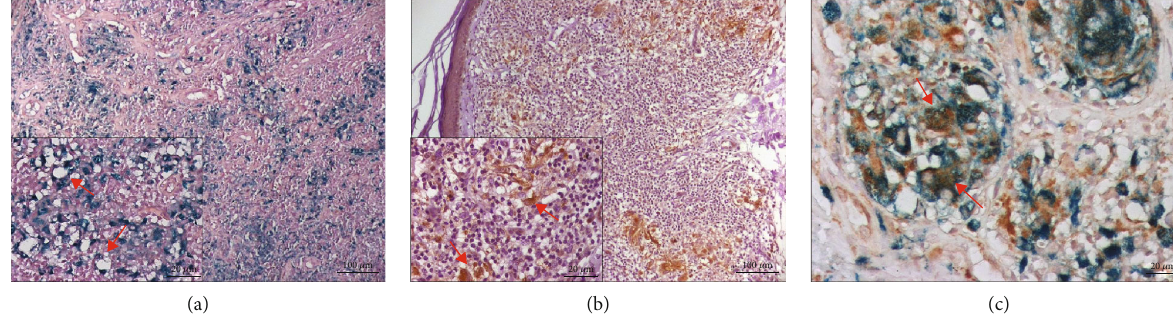
Figure 1: Histological sections of the skin lesion from nonulcerated or atypical cutaneous leishmaniasis (NUCL) processed by double- staining immunohistochemistry showing (a) CD68 + cells (blue), (b) iNOS + cells (brown), and (c) M1 macrophages (CD68 + /iNOS + ) ( × 400). The red arrows show immunostained cells for the di ff erent markers.